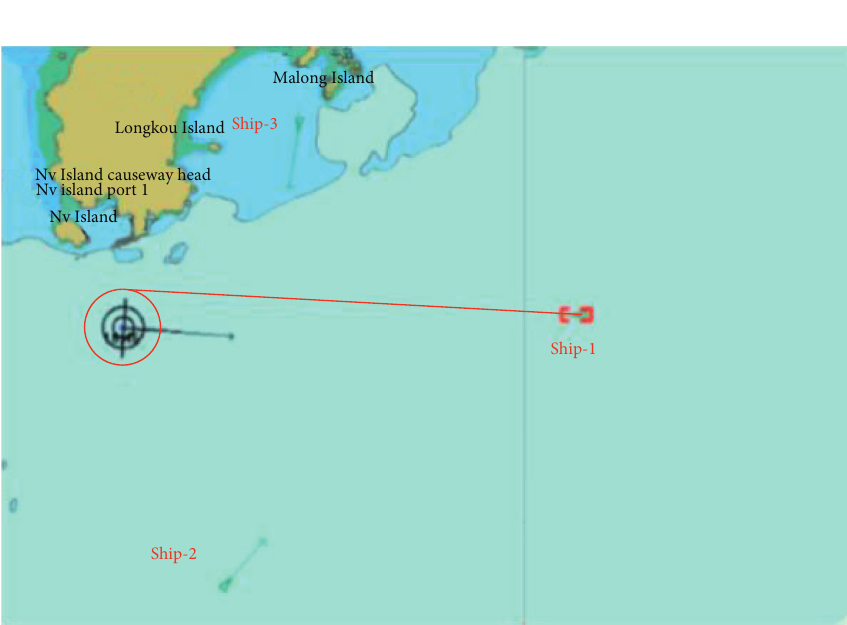
Figure 30: Initial simulation environment